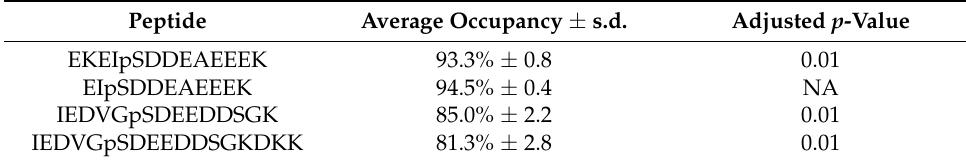
Table 3. Average occupancy and standard deviation (s.d.) determined for Hsp90 β immunopurified from conditioned medium of K562 suspension cultures ( n = 3). p -values from a t -test comparing the present occupancy values with K562 intracellular Hsp90 β occupancy values.